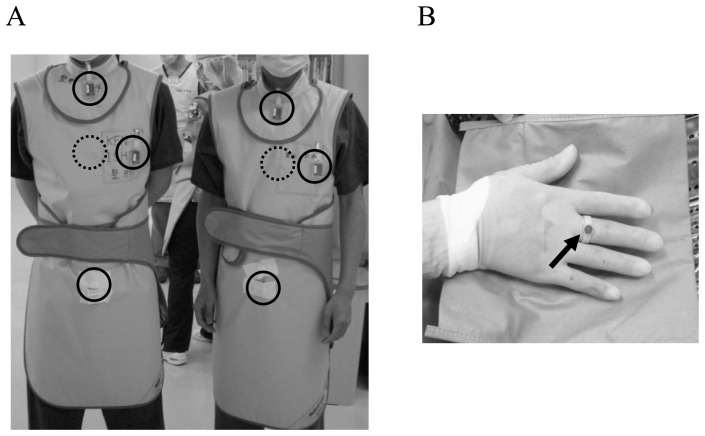
Placement of radiation monitors.The operating and assisting surgeon and radiological technologist wore thermoluminescent dosimeter (TLD) badges at the thyroid, chest, genitals (unshielded; circles in A), and on the chest (shielded; dotted circles in A). The operating and assisting surgeon wore sterile TLD ring badges on their right middle fingers (B).